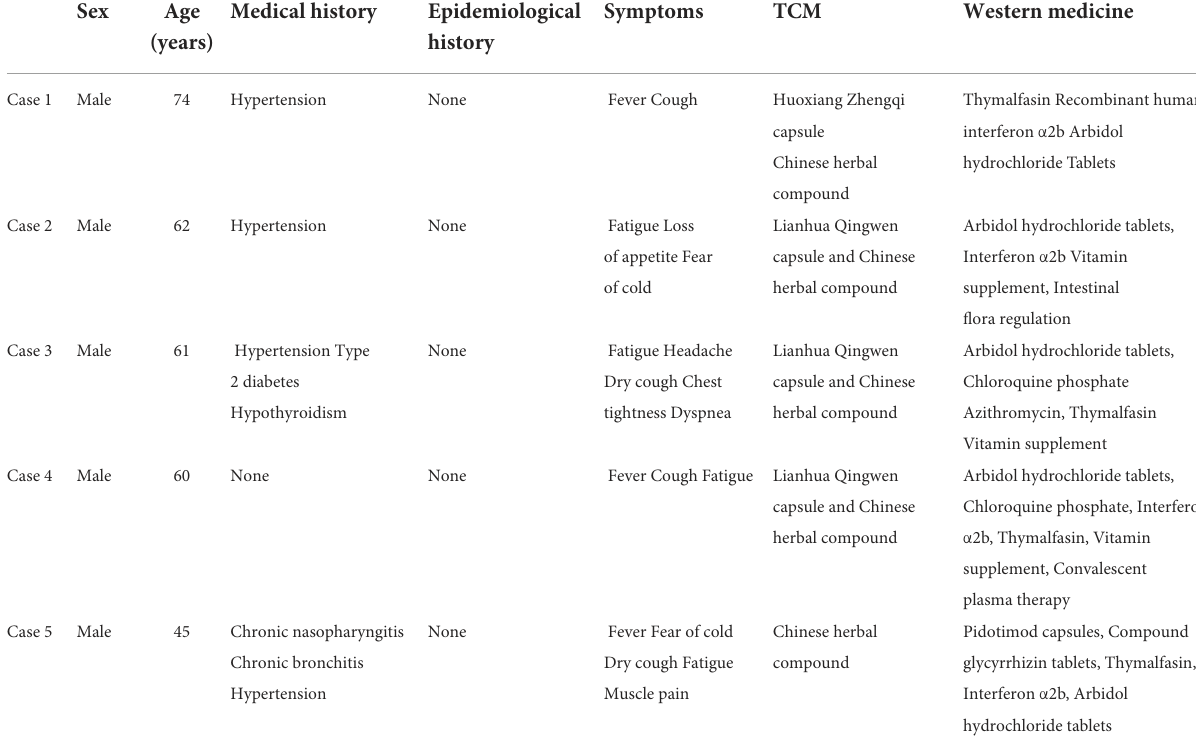
TABLE 1 Baseline characteristics of study